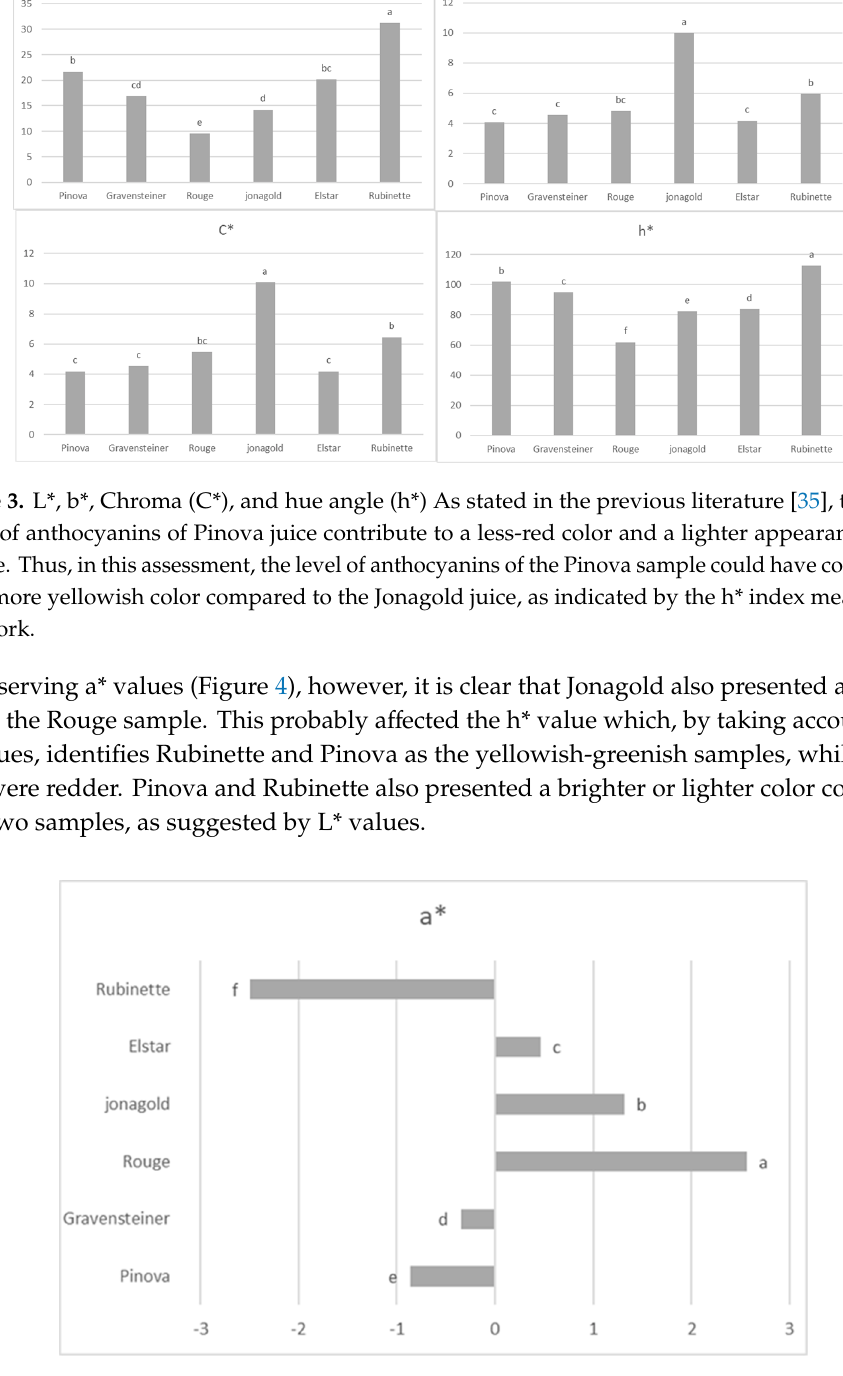
Figure 4. The a* values of apple juice samples. Different lower-case letters (a–f) show significant differences among treatments ( p ≤ 0.05).